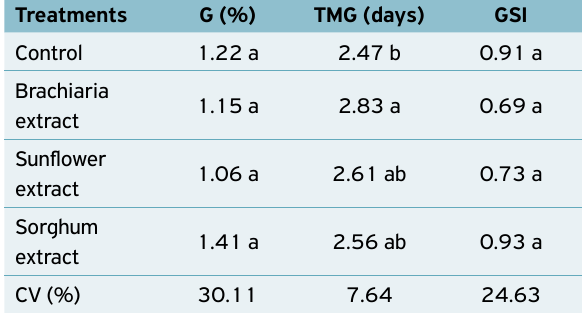
Table 2. Means of germination, mean germination time germination speed index of Bidens pilosa L. submitted to treatments with extracts, Cruz das Almas, BA, 2013.